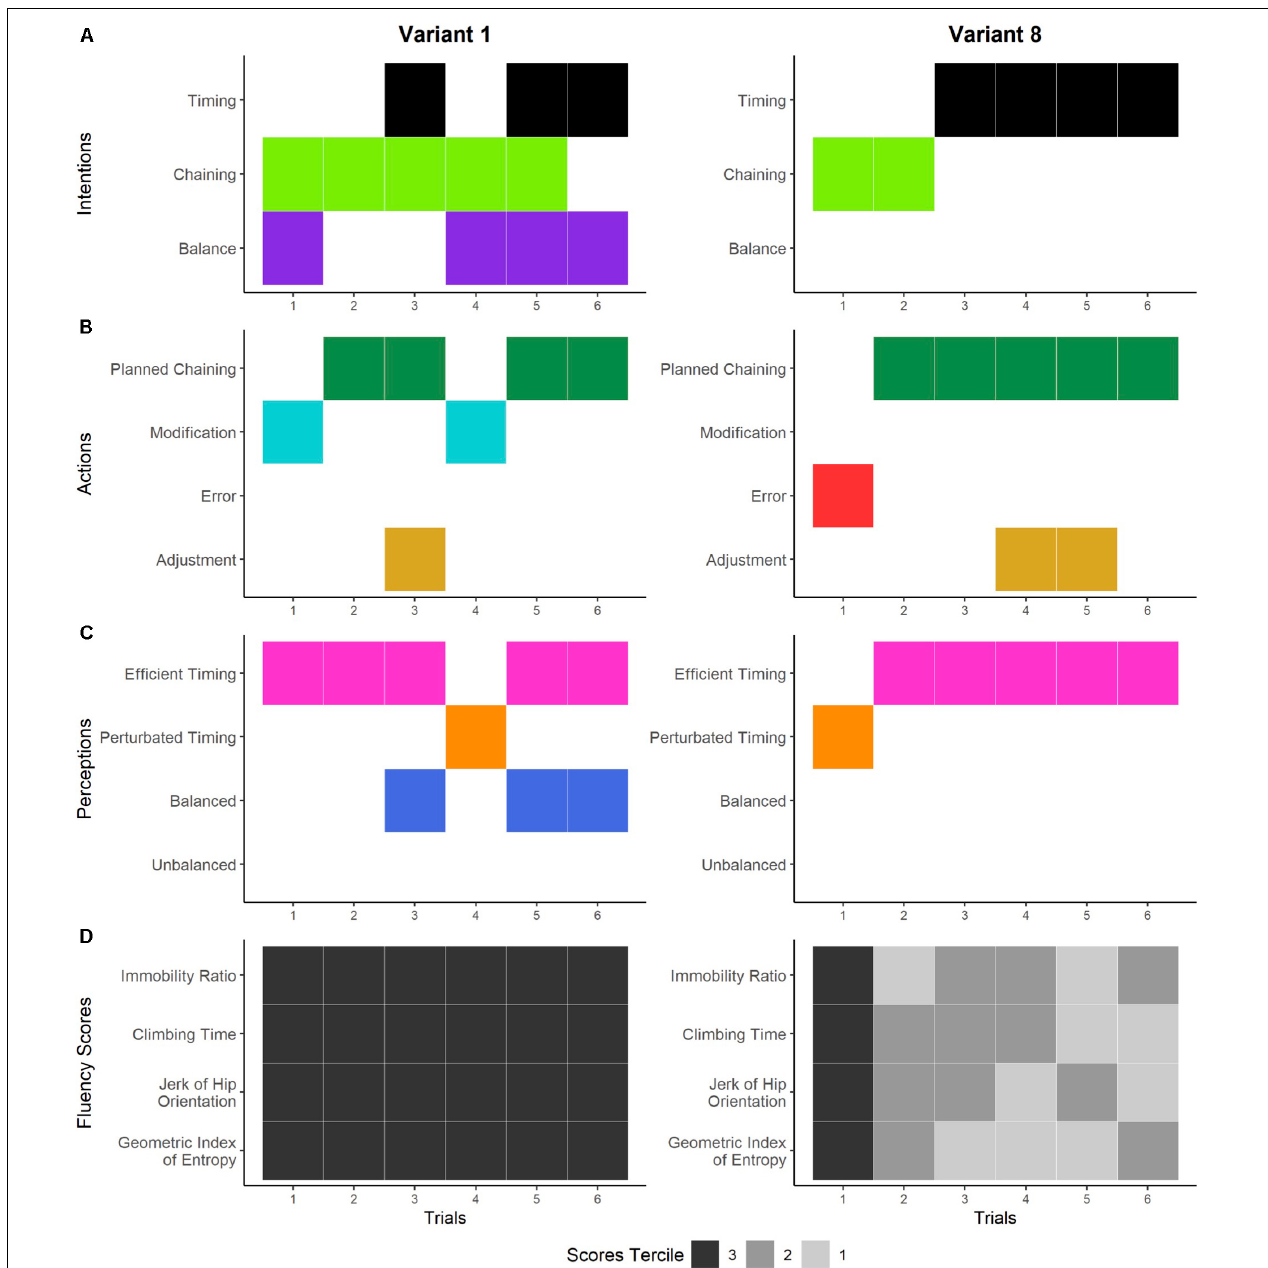
FIGURE 7 | Dynamics of the climber’s experience and performances on variants 1 and 8. Panels A–C show the temporal organization of the general dimensions of the different components of experience detected during the interviews. Panel A shows the general dimensions of the climber’s intentions: seeking and maintaining balance while climbing (purple), ensuring the correct execution of movement chaining (light green), and improving the timing of the climb (black). The climber’s actions are reported in panel B: adjusting the foot chaining while climbing (gold), making errors while climbing (red), deliberately modifying the planned movements while climbing (light blue), and carrying out the planned chaining (dark green). Panel C shows the general dimensions of the climber’s perceptions: sensation of being balanced (dark blue), sensations of being unbalanced (green), sensations of efficient timing (pink), and sensations of perturbed timing (orange). Panel D shows the score terciles for each fluency indicator. The climbing performance is expressed in the terciles: tercile 3 (in black) refers to his poorest performances, tercile 2 (in dark gray) refers to his intermediate performances, and tercile 1 (in light gray) refers to his best performances.